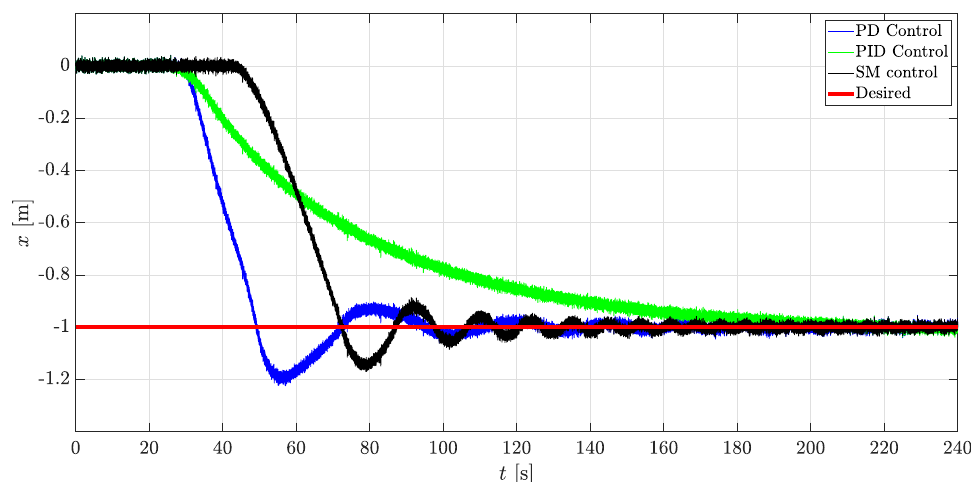
Figure 14. The translational behavior of the mini-AUV along I x .